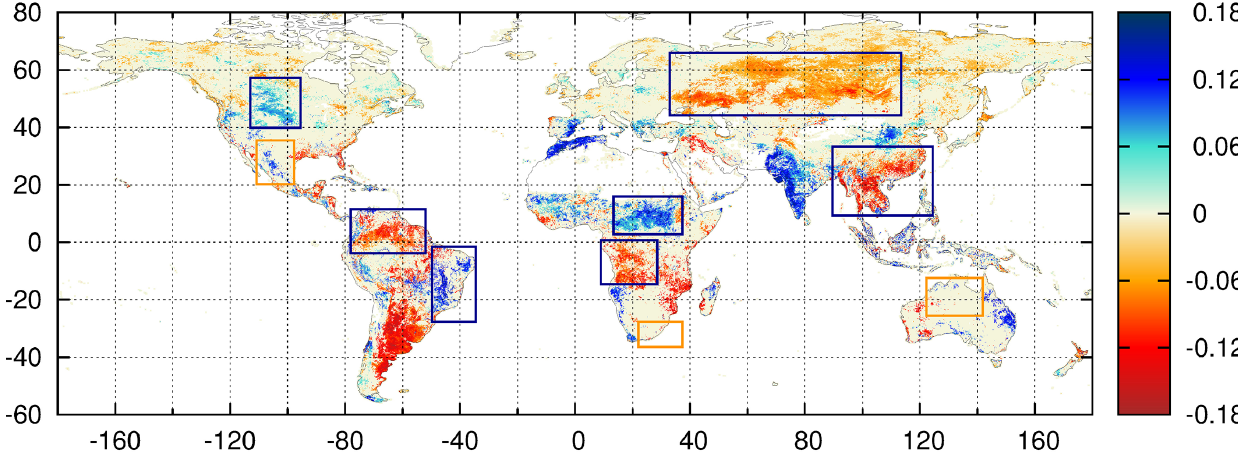
Figure 4. Geographic distribution of sites where DSI trends are significant at 2 σ or higher levels. Linear trend slopes in units of year − 1 are color coded. Blue rectangles denote areas where significant DSI trends are ET / PET dominated (based on a comparison with the map of Fig. 2a in Fensholt and Proud, 2012). Orange rectangles identify regions where NDVI trends are significant (see Fig. 2a in Fensholt and Proud, 2012), but DSI trends are missing or very